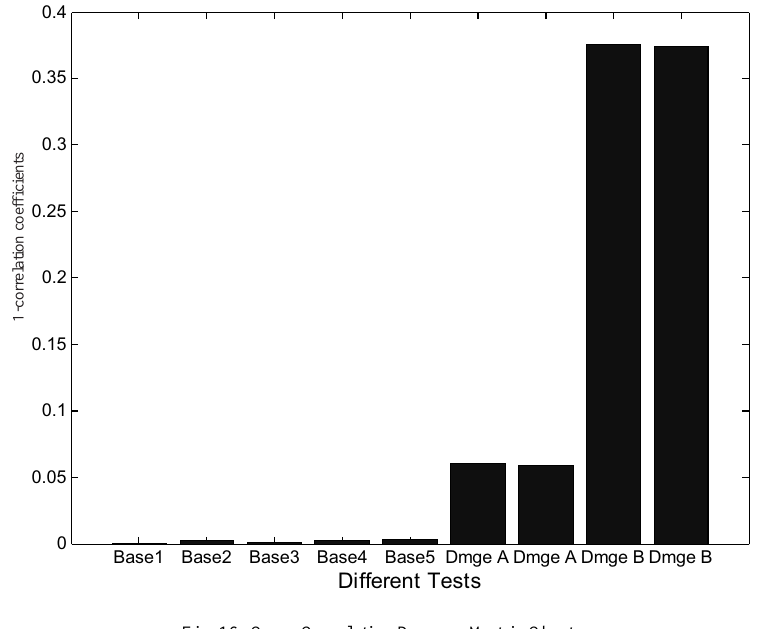
Fig. 16. Cross Correlation Damage Metric